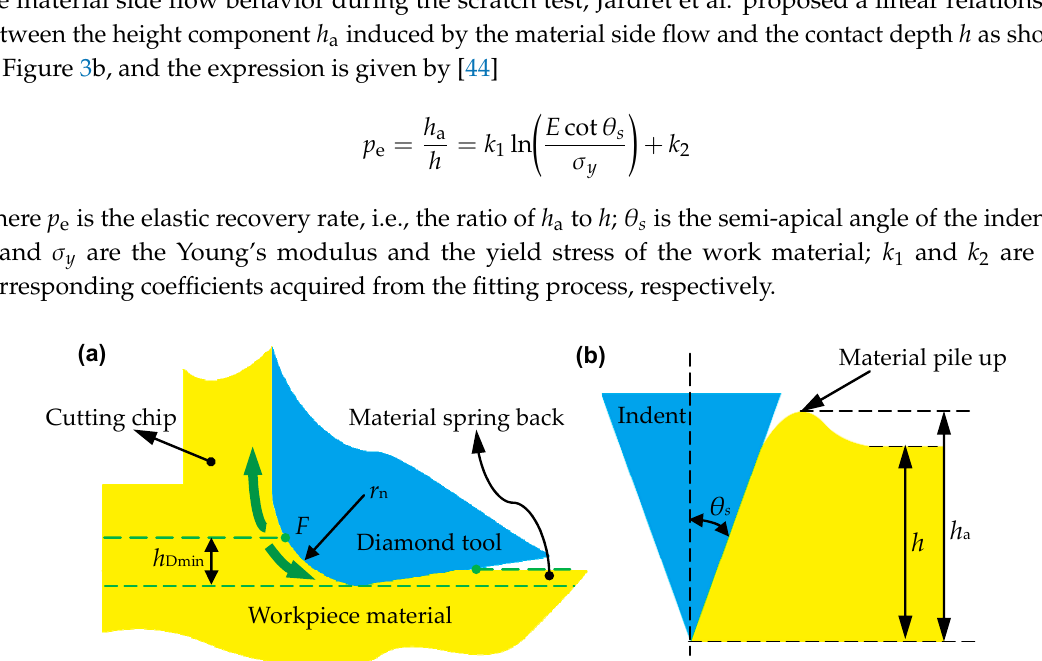
Figure 3. Illustration for the influence of minimum undeformed chip thickness and the calculation model of height of material pile up: ( a ) material removal process in orthogonal plane; ( b ) material pile up h a in relation to contact depth h . Reproduced with permission from [25,45].